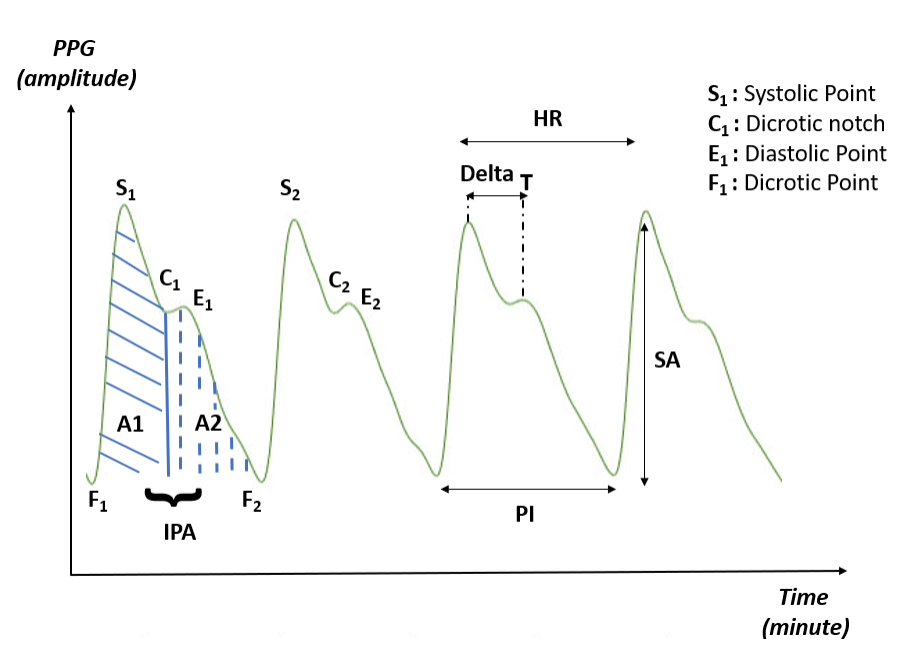
Figure 3. ( a ) The three phases of the photoplethysmography (PPG) signal acquisition: pre-occlusion (normal blood flow), occlusion (occluded flow), post-occlusion (restored flow). Dotted lines highlights a zoomed signal portion. (b) From the zoomed signal portion, the parameters useful for computing PPG features are highlighted.